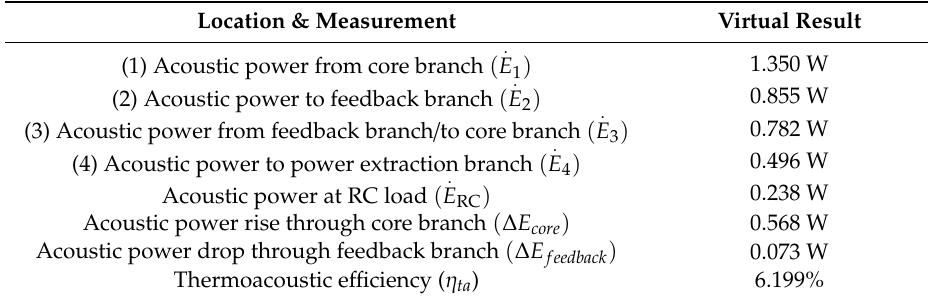
Table 2. Performance results at di ff erent locations of the proposed TA-SLiCE